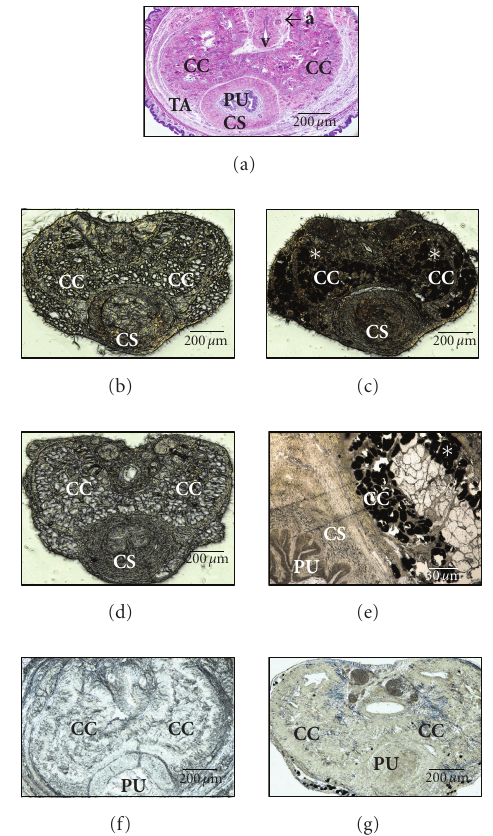
Figure 7: Micrograph sections from penile body of normal rat (a) and rats treated neonatally with DES (b)–(e) or DES + ICI (f)- (g). Panel (a) was from a normal adult rat stained with H and E for demonstration of normal histological structures of the penis (a: dorsal artery; v: dorsal vein; CC: corpus cavernosum; CS: corpus spongiosum; PU: penile urethra; TA: Tunica albuginea). Panels ((b), unstained) and ((c), stained for fat with 1% osmium tetroxide) were from a 28-day-old rat. Panels ((d), unstained) and ((e), stained for fat with 1% osmium tetroxide and presented as a magnified view of CC and CS regions) were from adult rat (120 days) treated neonatally with DES. Note the empty appearing spaces of fat cells in CC regions in unstained sections (panels (b) and (d)). In sections stained with 1% osmium tetroxide (to confirm presence of fat) fat cells appear as black granules, ∗ . Panels ((f), unstained) and ((g), stained with 1% osmium tetroxide) were from a 28-day-old rat treated neonatally with DES + ICI. Note the absence of empty appearing fat cells and lack of fat staining in CC region. Sections from these rats were used for immunolocalization of PPAR γ in Figure 6 parts (a) & (b). Scale bars = 30 (E) and 200 μ m in other